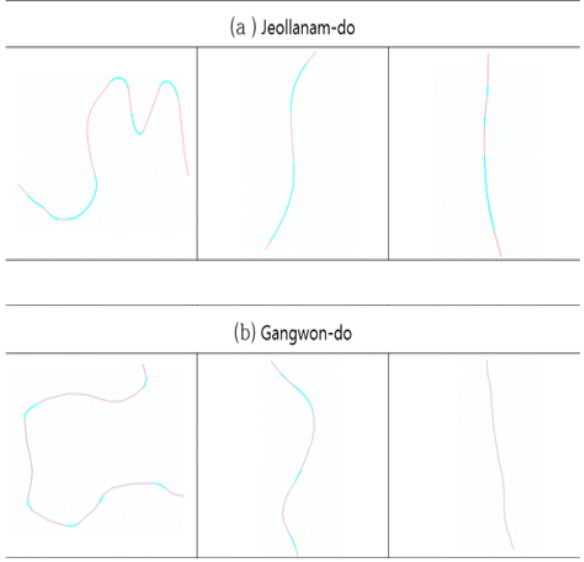
Figure 2. Comparison of coastline vertex interval